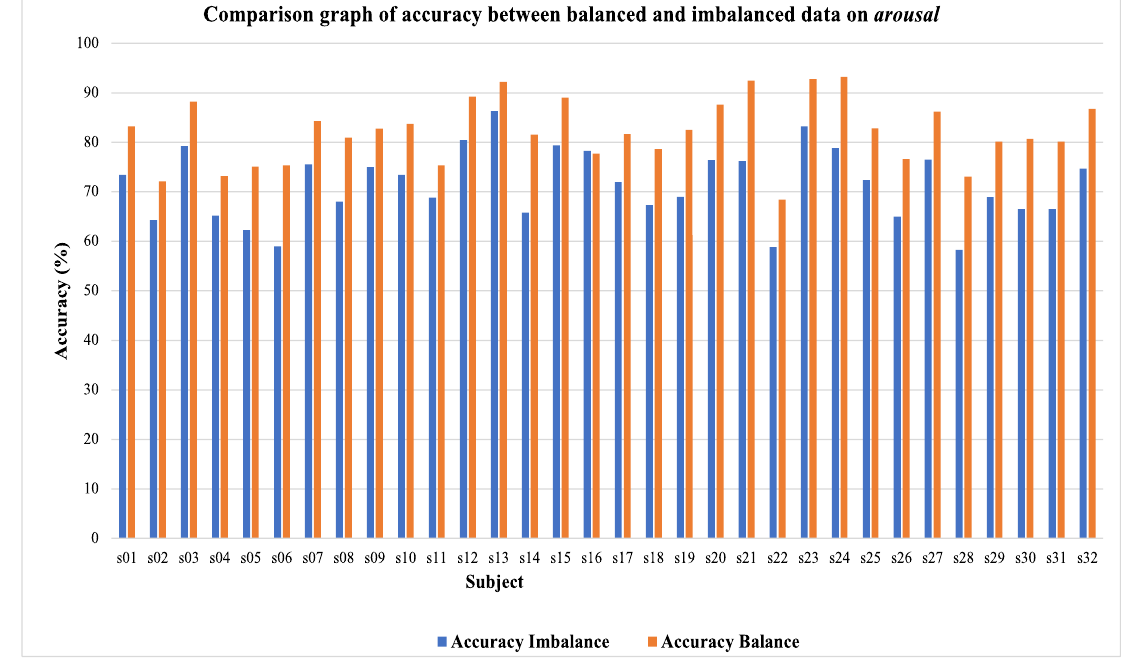
Figure 10. Comparison of arousal accuracy for using CNN and with or without the Radius SMOTE